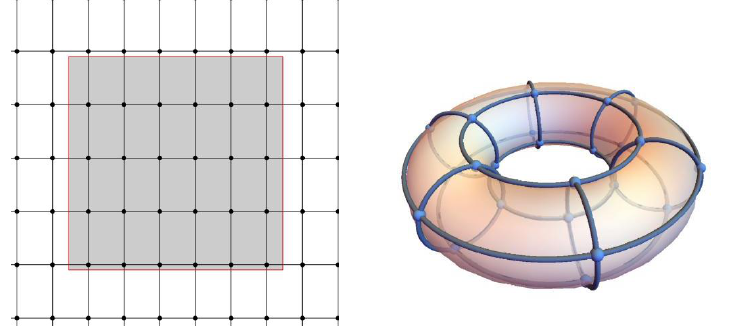
Figure 11. The drawing for ( m , n ) = ( 6,4 )